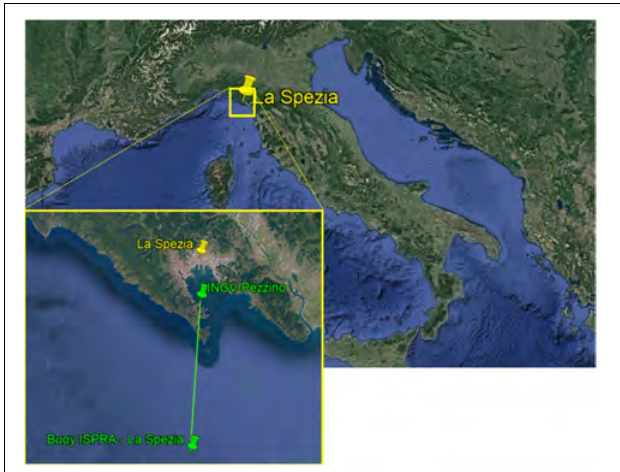
FIGURE 2 | Locations of La Spezia city (yellow marker), OS-IS station (INGV-Pezzino, green marker), and buoy ISPRA-La Spezia (green marker). The distance, indicated by the green line, between OS-IS and the buoy is about 16 km.